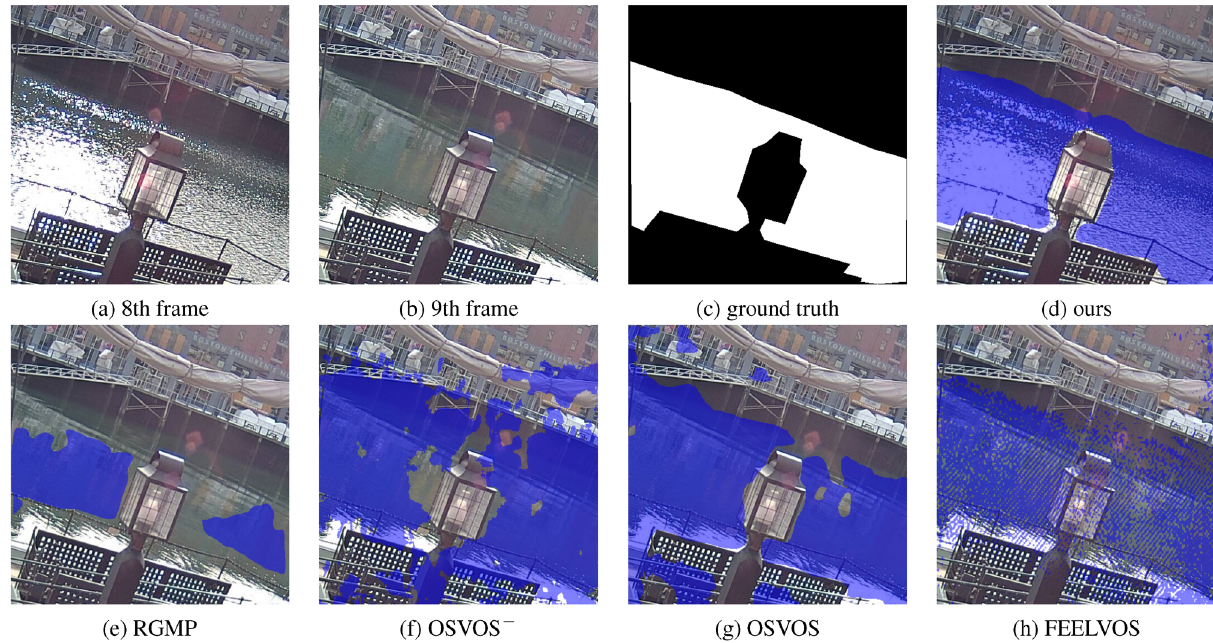
Fig. 8 Qualitative results from test video “Boston Harbor”: (a) 8th frame, (b) 9th frame for segmentation, (c) ground-truth water, (d)–(h) segmentations of WaterNet, RGMP, OSVOS without online training, OSVOS, and FEELVOS.